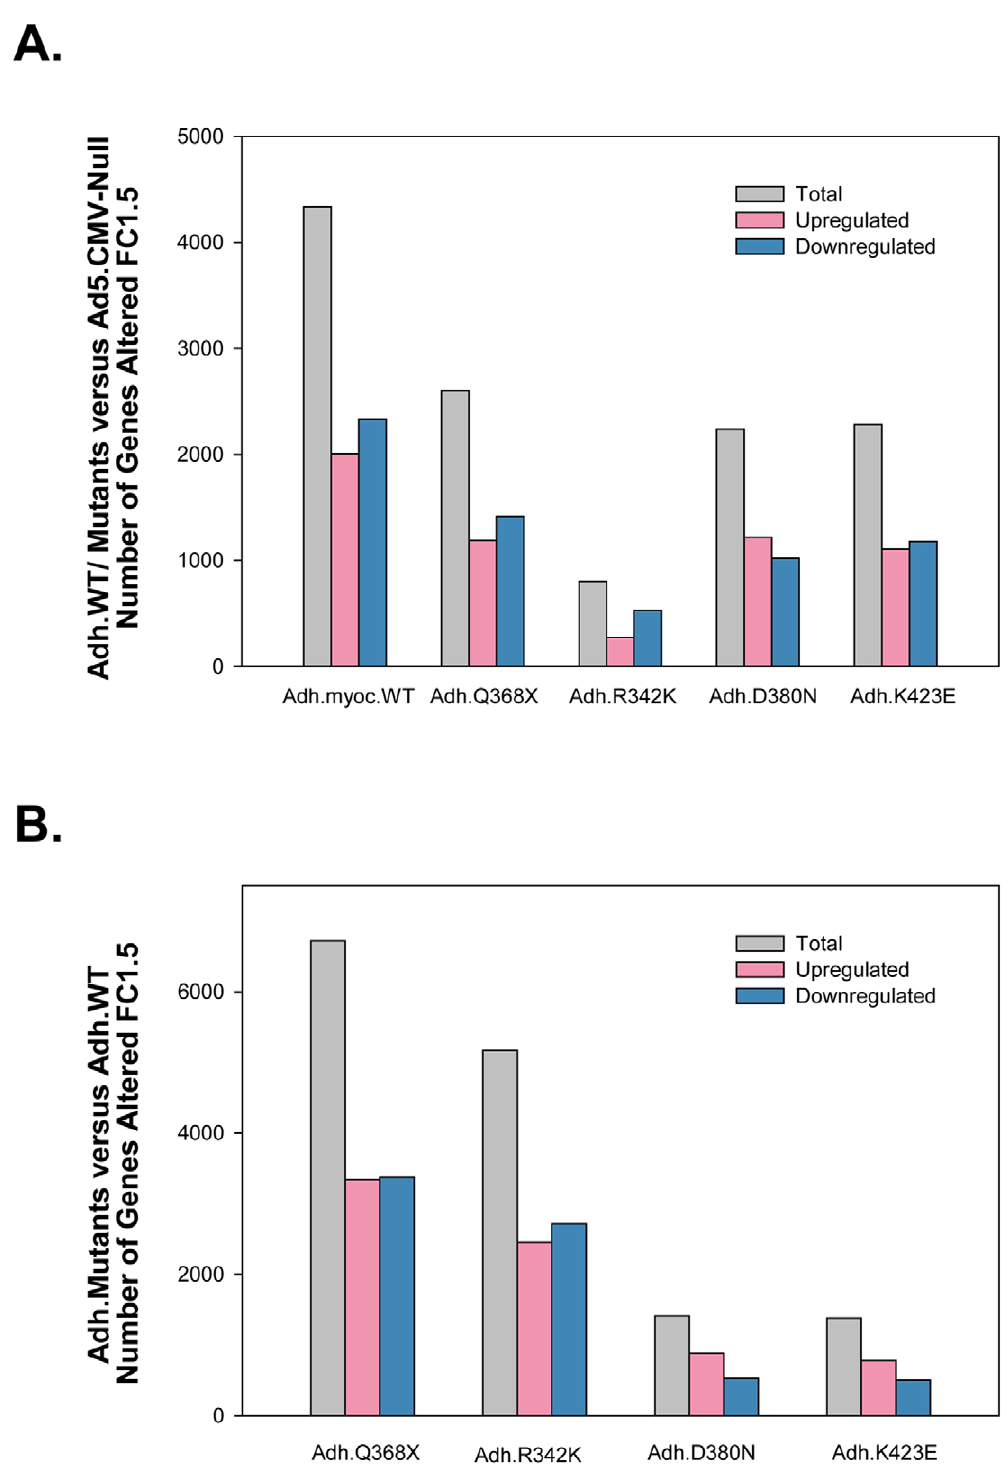
Figure 2. Wild-type MYOC and different MYOC mutants alter different gene numbers on the trabecular meshwork transcriptome. Adenoviral vectors carrying either wild type, four MYOC mutations cassettes or no transgene (Ad5.CMV-Null) were infected on primary human trabecular meshwork cell line HTM-72 to overexpress MYOC proteins. The expression of genes in the wild-type or mutant-treated cells was obtained using Affymetrix GeneChips (n=17). GeneSpring 10 and Excel software were used to generate non-redundant gene lists with cutoff fold-change values of $ and # 1.5. A: number of genes altered in cells treated with the wild-type or each of the mutants compared with the number altered in cells treated with the empty virus (Adh.WT/Mutants versus Ad5.CMV-Null). B: number of genes altered in cells treated with the each of the mutants compared with the number altered in cells treated with the wild type virus (Adh.Mutants versus Adh.WT).